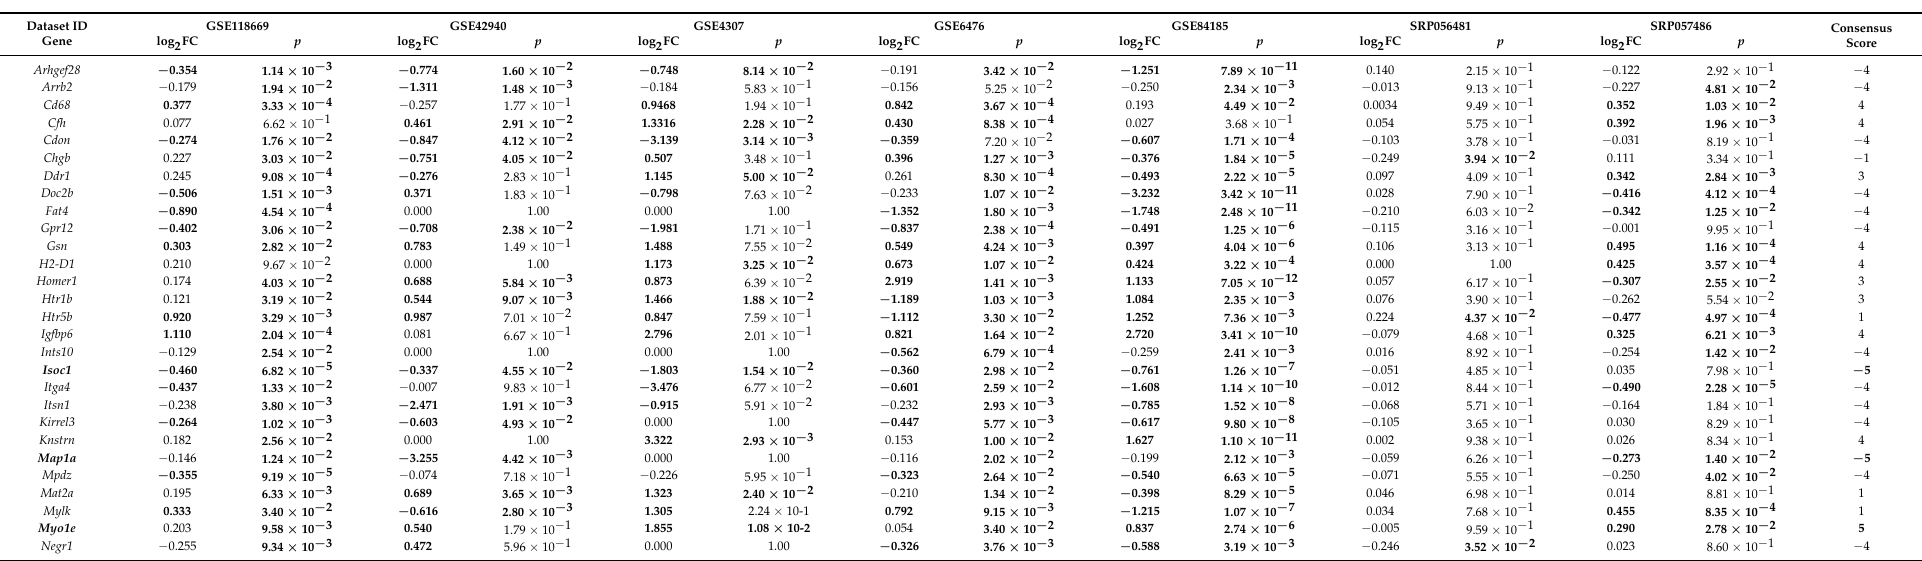
Table 6. Signature of FLX effect in naïve animals (integration